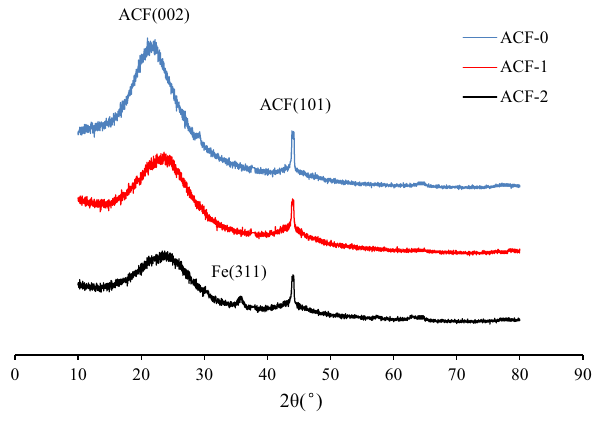
Fig. 3 XRD analysis of ACF-0, ACF-1 and ACF-2